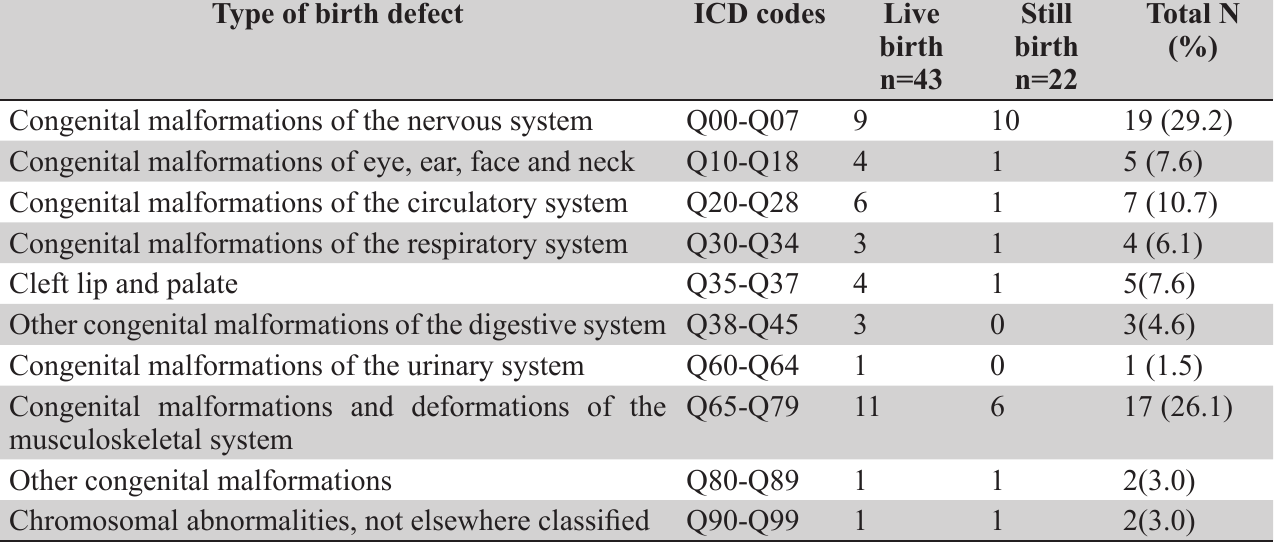
Table 1. Type of birth defects in live and still births